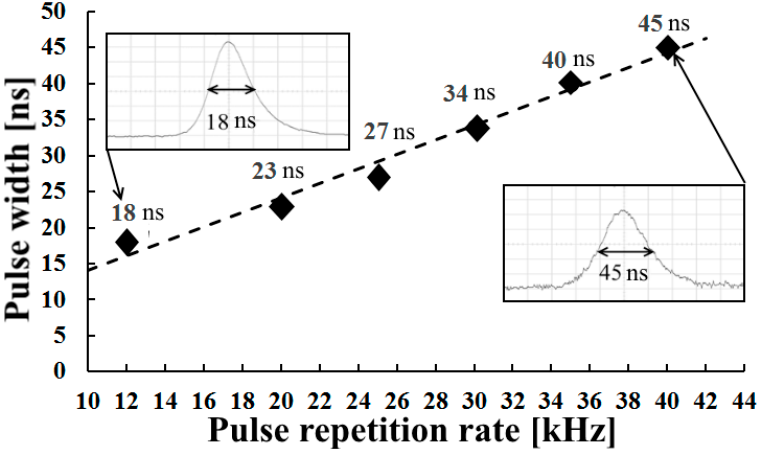
Figure 4. Dependences of the laser pulse width on their repetition rate for a Ho 3+ :YAG laser.